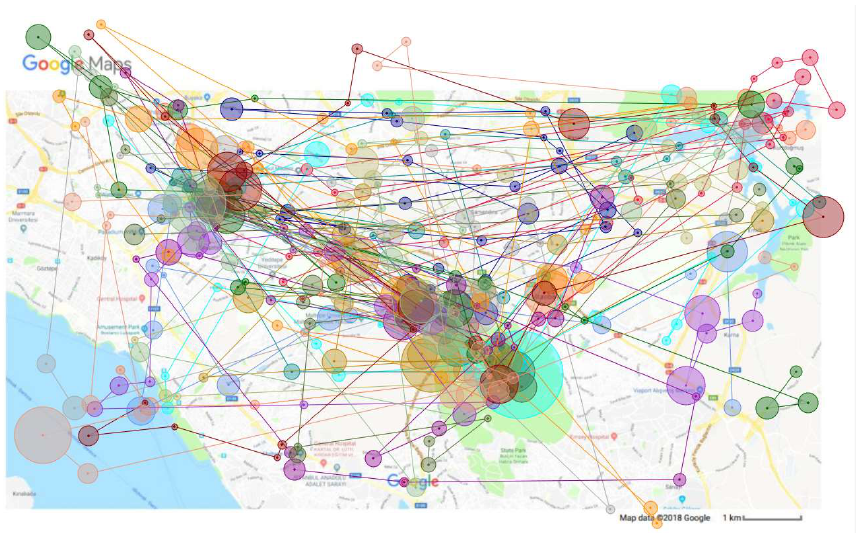
Figure A4. Larger version of Figure 8b.